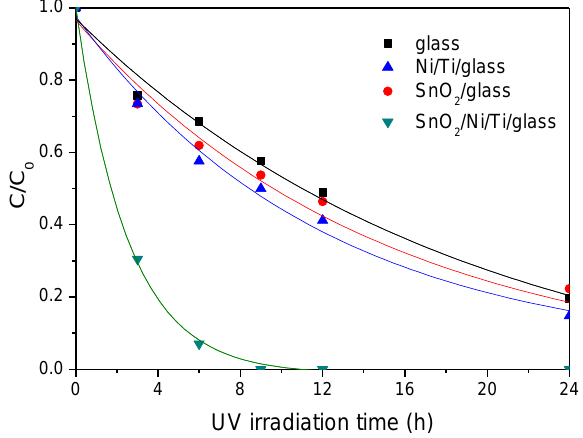
Figure 10. Residual MB concentration (C/C 0 ) versus UV irradiation time for characterizing photocatalysis of 350 °C-deposited TiO 2 films on various indicated underlying materials.